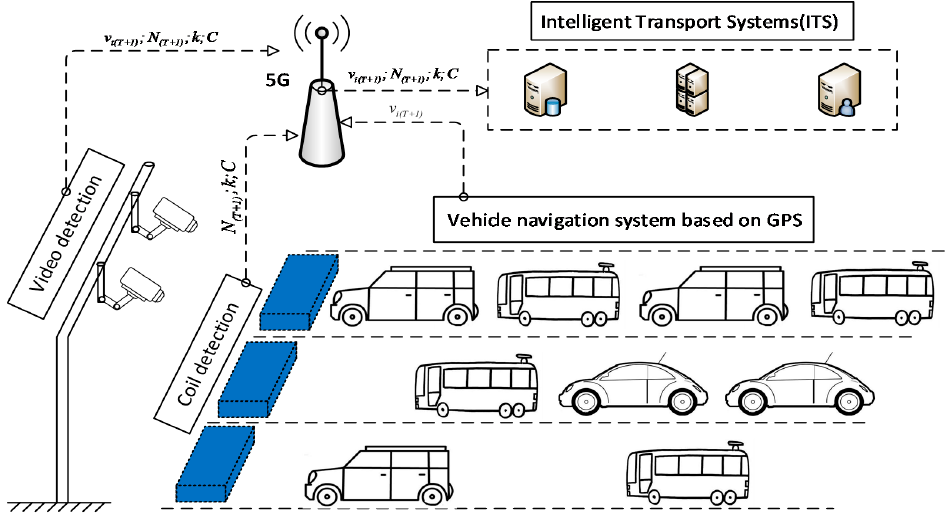
Figure 1. Real-time traffic flow data system in 5G-IoV.